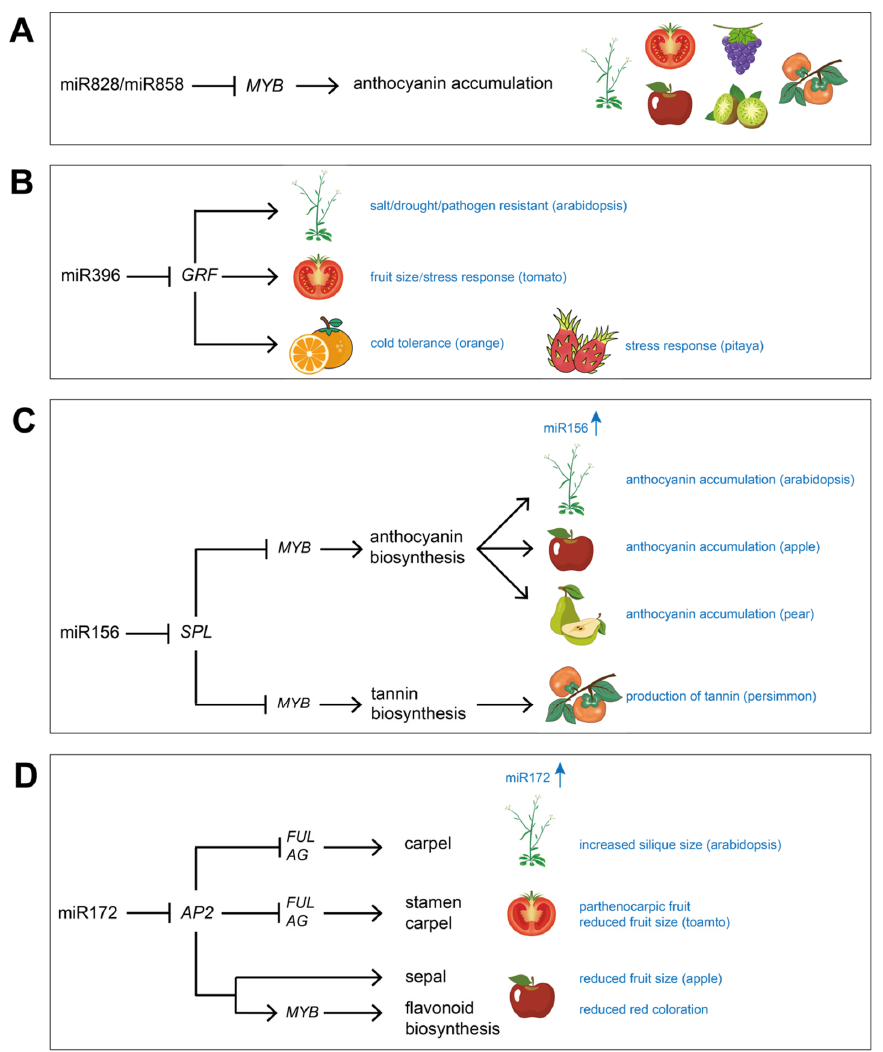
Figure 2. Models of miRNA regulatory modules in fruit crops. ( A ) The miR828/miR858- MYB module regulates anthocyanin accumulation in Arabidopsis , tomato, apple, grape, kiwifruit and persimmon, respectively. ( B ) The miR396- GRF module regulates plant growth and stress response in Arabidopsis , tomato, orange and pitaya, respectively. ( C ) The miR156- SPL module regulates fruit metabolism in Arabidopsis , apple, pear and persimmon, respectively. ( D ) The miR172- AP2 module regulates fruit size and anthocyanin biosynthesis in Arabidopsis , tomato and